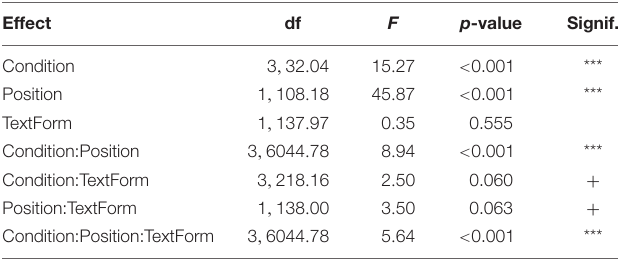
TABLE 7 | Mixed model ANOVA table for Experiments L2A and L2B (non-native participants). Effect df F p -value